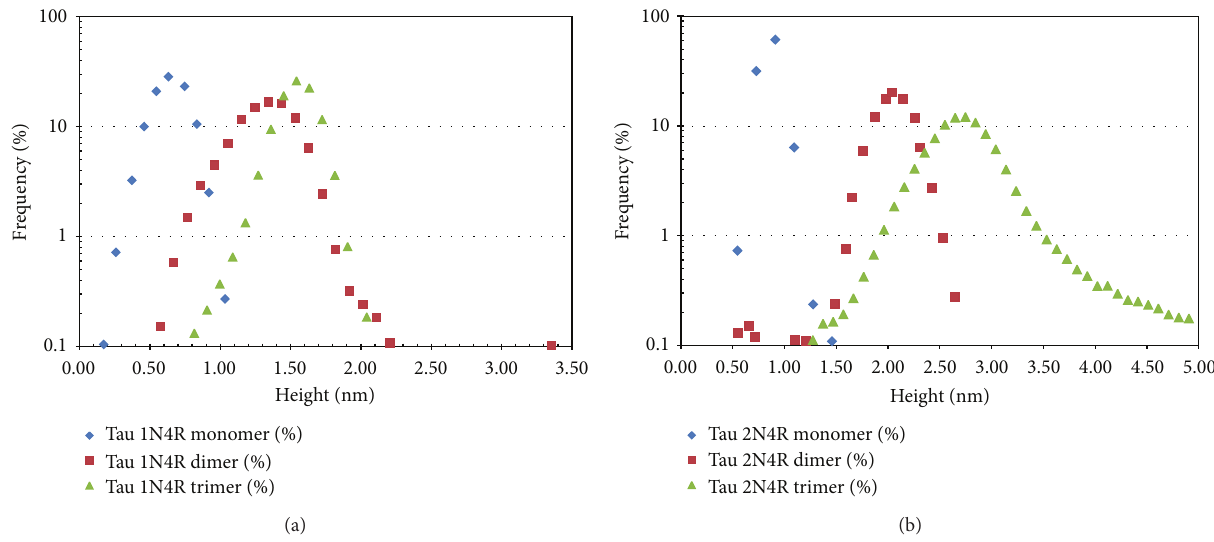
Figure 4: Plots of height distribution of monomeric, dimeric, and trimeric fractions of rhTau 1N4R (a) and tau 2N4R (b). The height value of each particle was measured using Gwyddion. The numbers of particles falling in continuous size ranges were calculated and normalized into count percentages. The peak values give an approximate value for each tau species particle size. As expected, high-degree oligomers are larger than low-degree oligomers within the same isoform, and corresponding oligomeric aggregates from the longer isoform are larger than aggregates from the shorter isoform.